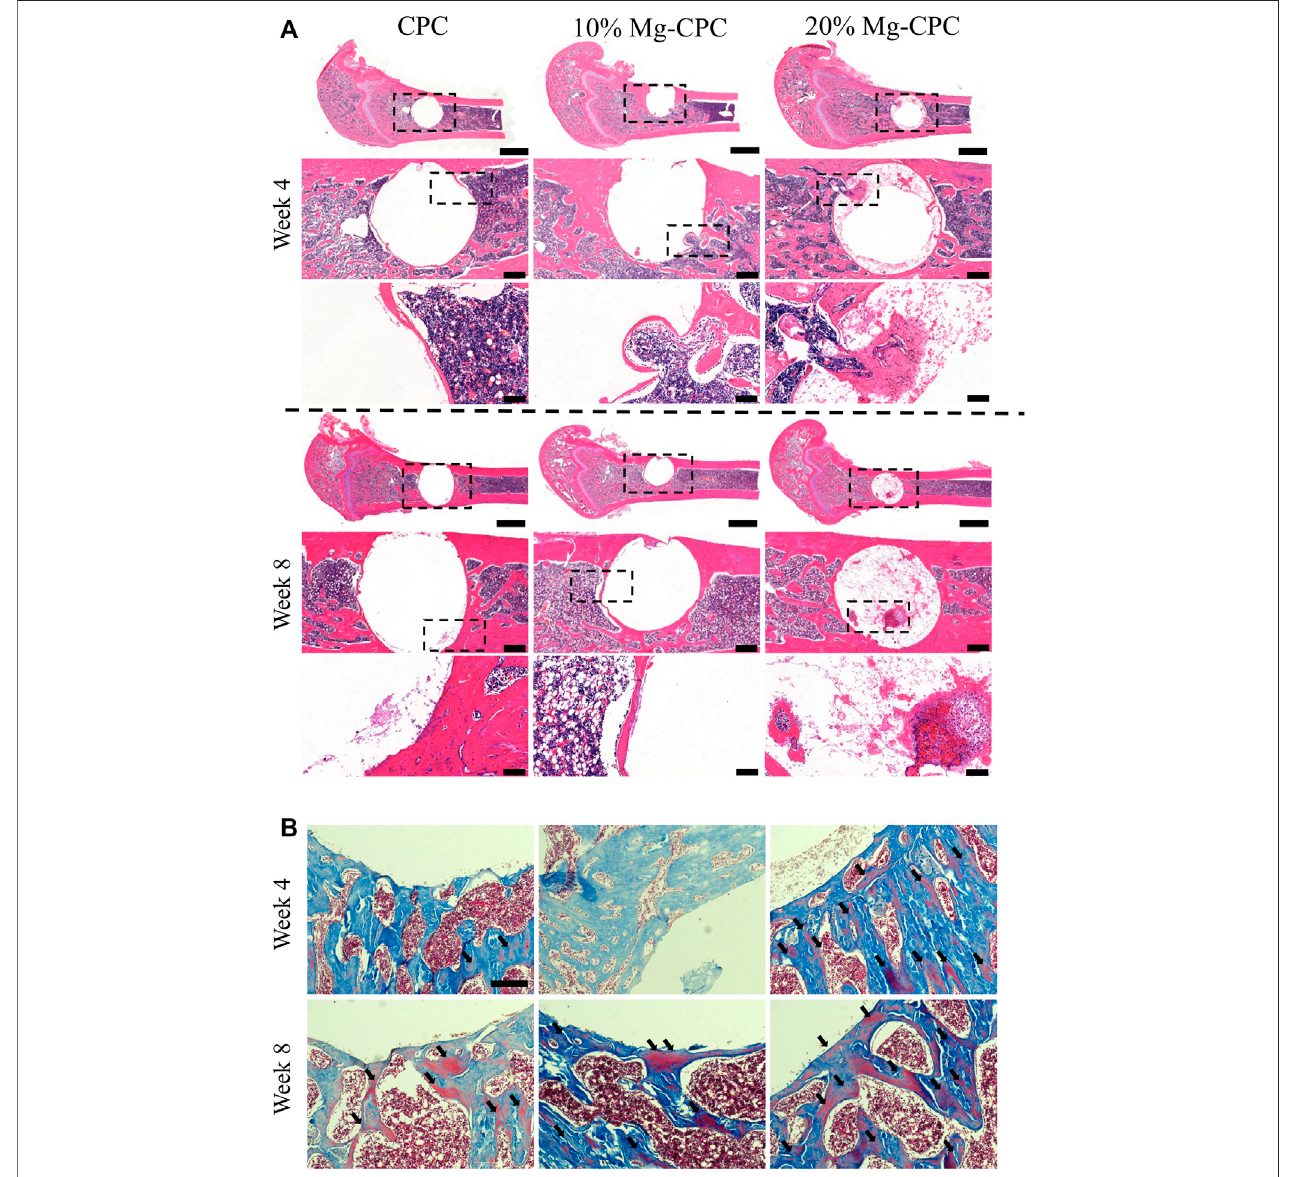
FIGURE 5 | Histological staining after surgery. (A) H&E staining (scale bar (cid:2) 2,000, 500, 100 μ m); (B) Masson trichrome stain, red color represents mature bone (back arrow). Scale bar: 200 μ m.